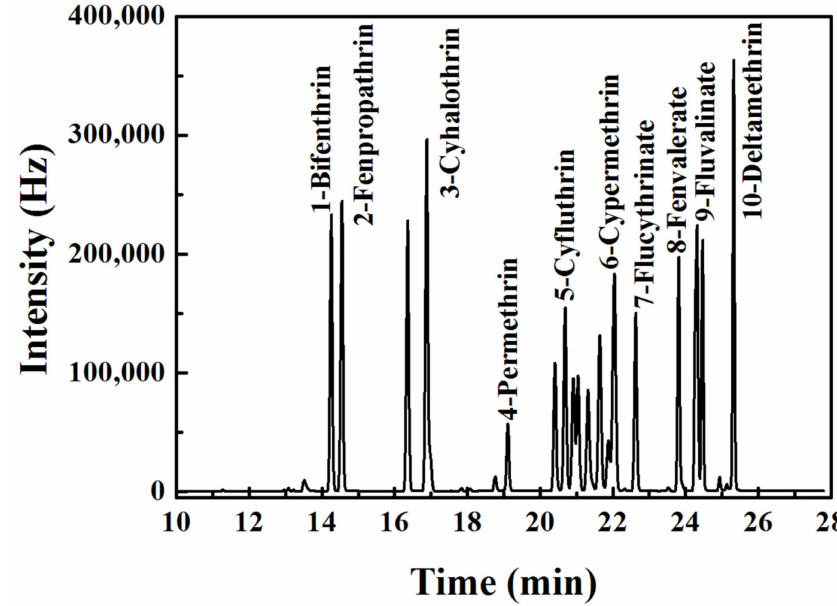
Figure 1. Chromatograms of 10 pyrethroid